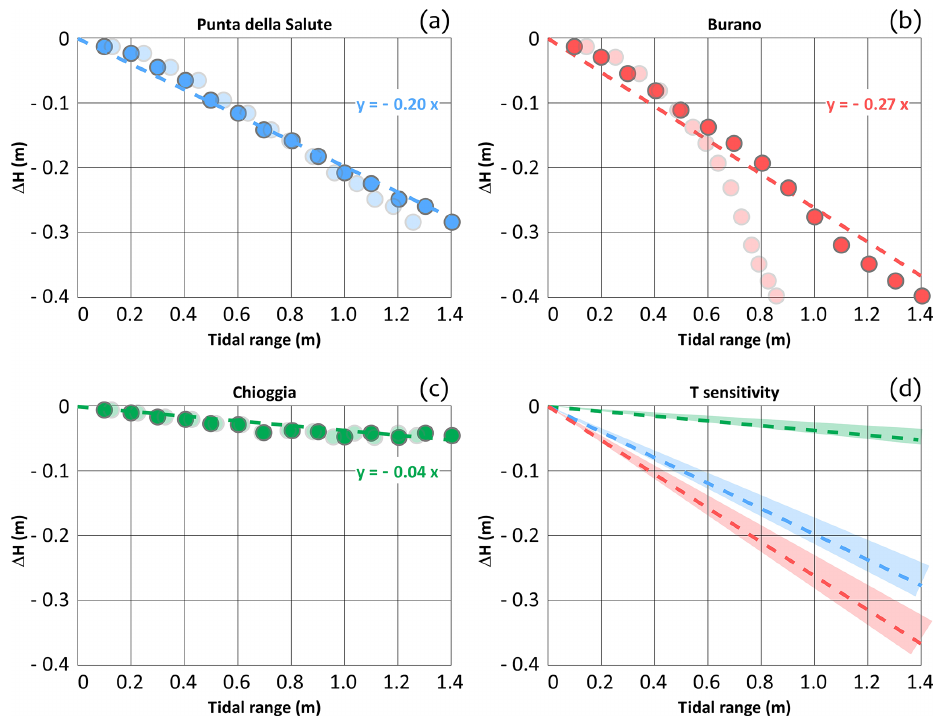
Figure 3. Synthetic sinusoidal tide; no wind condition (scenario I). Reduction of the sea level peak ( (cid:49)H ) due to a partial use of the Mo.S.E. system (Lido inlet closed, PCL). (a–c) Tidal period of 6h. (a) Punta della Salute; (b) Burano; (c) Chioggia. Solid bullets refer to the seaward tidal range and opaque bullets to the tidal range computed at the specific lagoonal gauge. (d) Effect of the tide period on the slope of the linear regression (range 4–8h). Dashed lines refer to the relationships computed for a tidal period of 6h at PS (blue, panel a ), Burano (red, panel b ), and Chioggia (green, panel c